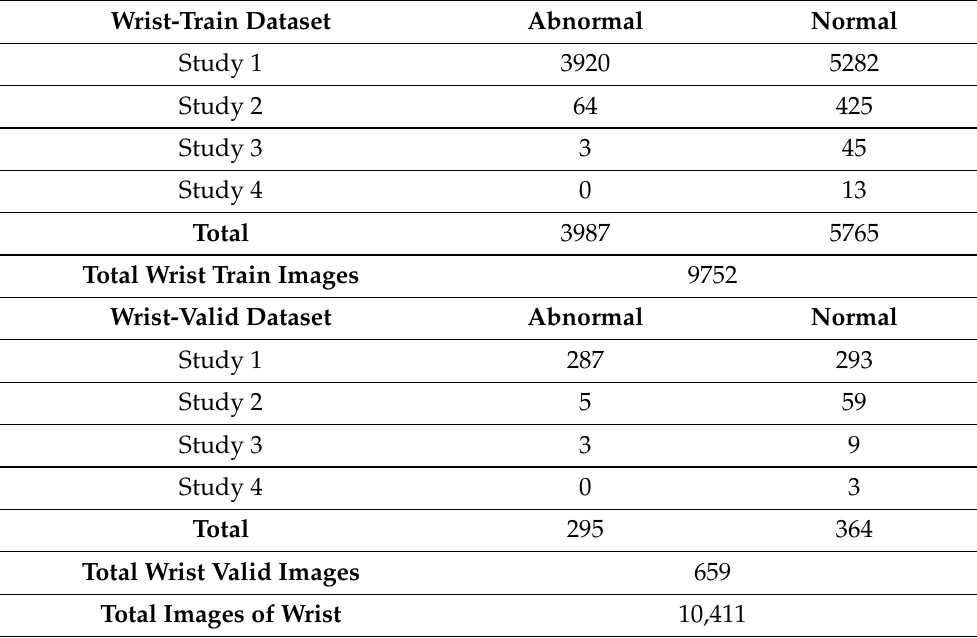
Table 2. Details of the number of wrist radiographs. Studies 1, 2, 3 and 4 refer to a patient visit identifier; each patient may have visited the hospital several times. A positive label corresponds to an abnormal condition, whereas negative corresponds to a normal condition as decided by the